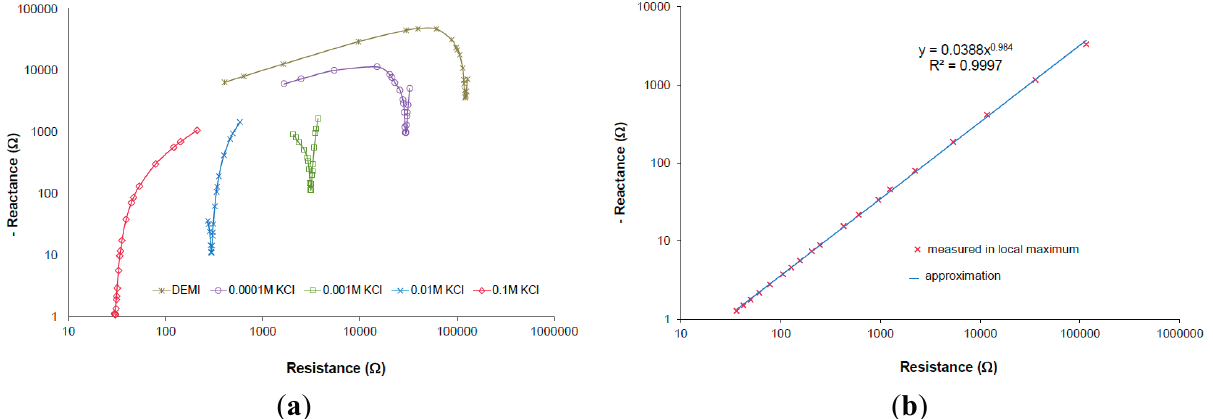
Figure 5. ( a ) Impedance in logarithmic Nyquist plot of different electrolyte concentrations measured by IDEs, parameters: 1 mm spacing, 1 mm electrode width, 7 mm length, six fingers; ( b ) Complex plain presenting impedance taken at local maximum for different conductivity/concentration of measured electrolyte. Reprinted from [25], Copyright (2015), with permission from